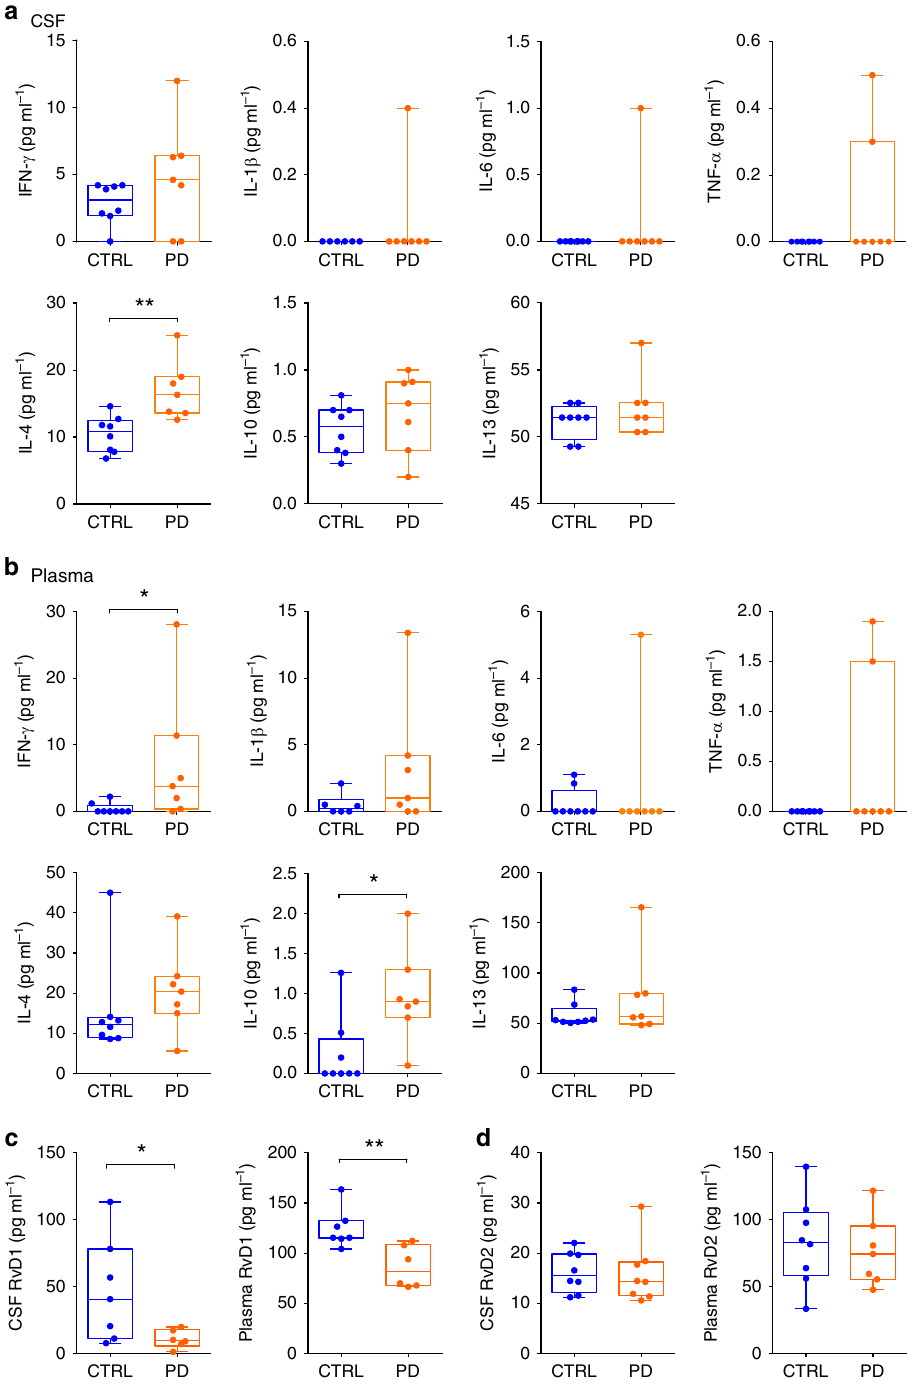
Fig. 9 CSF and plasma cytokines and resolvins in PD patients and control subjects. a Quanti fi cation with ELISA of CSF levels of pro- and anti-in fl ammatory cytokines in control subjects (CTRL) and PD patients (IFN- γ : 8 CTRL and 7 PD, P = 0.183; IL-1 β : 6 CTRL and 7 PD, P > 0.999; IL-6: 8 CTRL and 7 PD, P = 0.467; TNF- α : 8 CTRL and 7 PD, P = 0.200; IL-4: 8 CTRL and 7 PD, ** P = 0. 004; IL-10: 8 CTRL and 7 PD, P = 0. 294; IL-13: 8 CTRL and 7 PD, P = 0.436, all with Mann – Whitney test). b Quanti fi cation with ELISA of plasma levels of cytokines in CTRL and PD patients (IFN- γ : 8 CTRL and 7 PD, * P = 0.013; IL-1 β : 6 CTRL and 7 PD, P = 0.169; IL-6: 8 CTRL and 7 PD, P > 0.999; TNF- α : 8 CTRL and 7 PD, P = 0.200; IL-4: 8 CTRL and 7 PD, P = 0.121; IL-10: 8 CTRL and 7 PD, * P = 0. 013; IL-13: 8 CTRL and 7 PD, P = 0.515, all with Mann – Whitney test). c Quanti fi cation of CSF and plasma levels of RvD1 in CTRL and PD patients (7 CTRL and 6 PD patients; CSF: * P = 0.049; Plasma: ** P = 0.007, with two-tailed Welch ’ s t -test). d Quanti fi cation of CSF and plasma levels of RvD2 in PD and CTRL patients. No differences were detected between the two groups (CSF: 8 CTRL and 8 PD patients; P = 0.936; Plasma: 8 CTRL and 7 PD patients P = 0.667, with two-tailed Welch ’ s t -test). Source data are provided as a Source Data fi